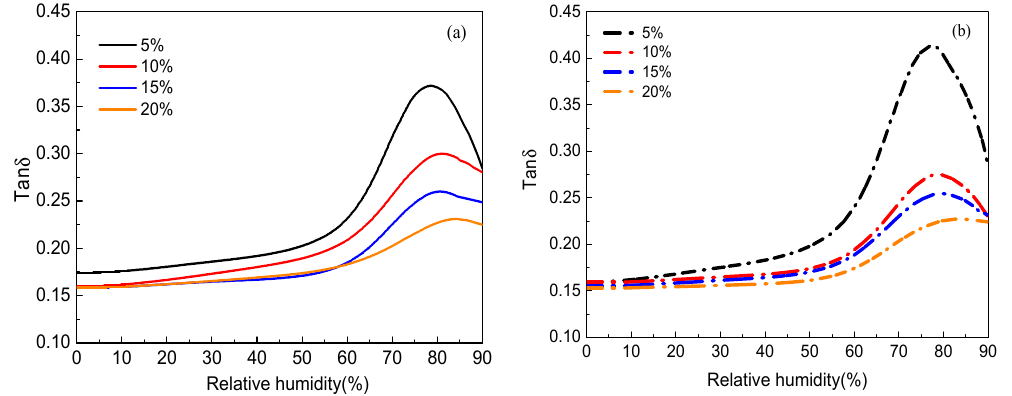
Figure 4. Effect of crosslinker content on RH-dependent loss tangent (tan δ ) of ( a ) xPVAc/EMDI and ( b ) xPVAc/ p -MDI.